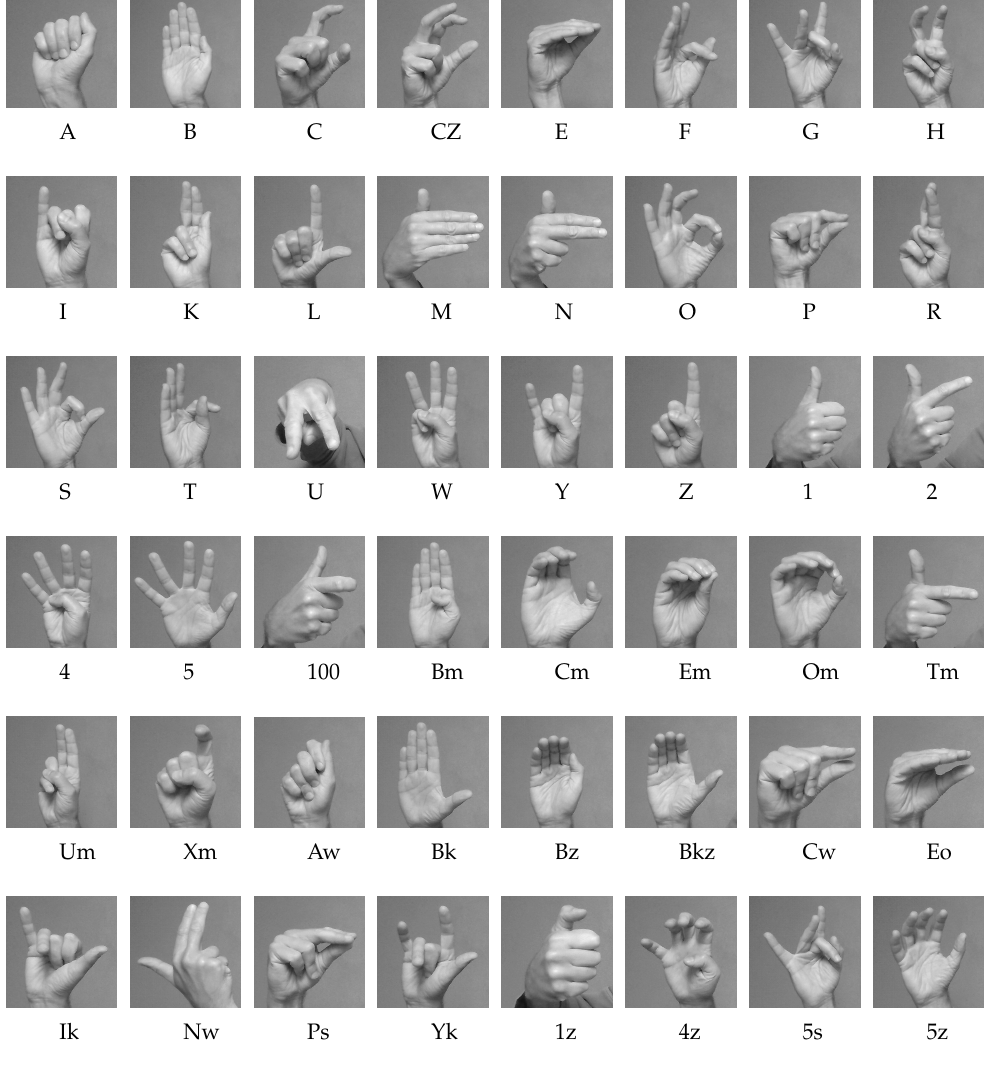
Figure 2. Hand postures of Dataset